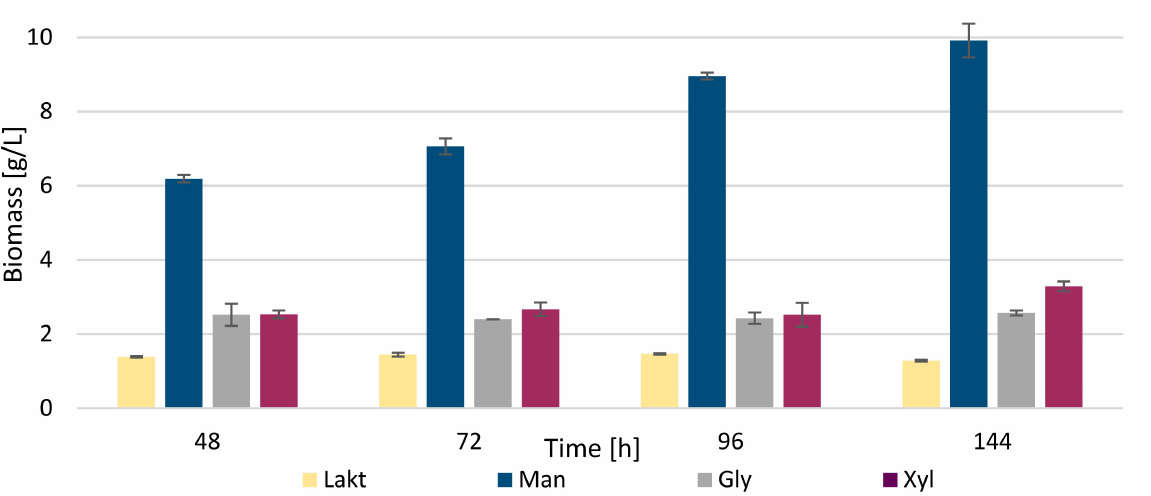
Figure 4. Biomass production with diverse carbon sources and with urea as nitrogen source. Abbreviations: Lakt: lactose; Man: mannose; Gly: glycerol; Xyl: xylose. Table 6. Biomass composition of R. kratochvilovae CCY 20-2-26 cultured on different carbon sources with urea.